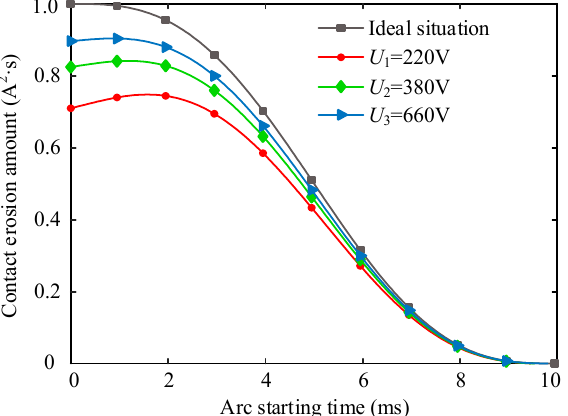
Figure 7. CEA curve with AST under different supply voltages.